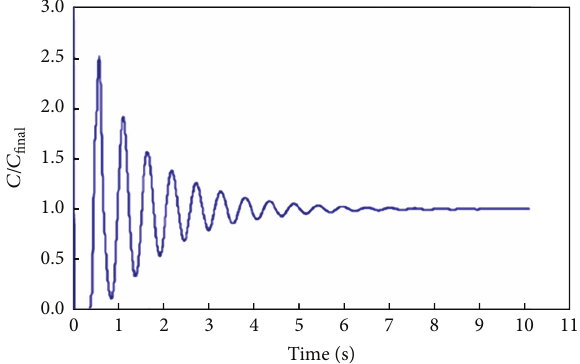
Figure 7: Time evolution of the normalized concentration averaged on the monitor surface by Pramparo et al. 2008